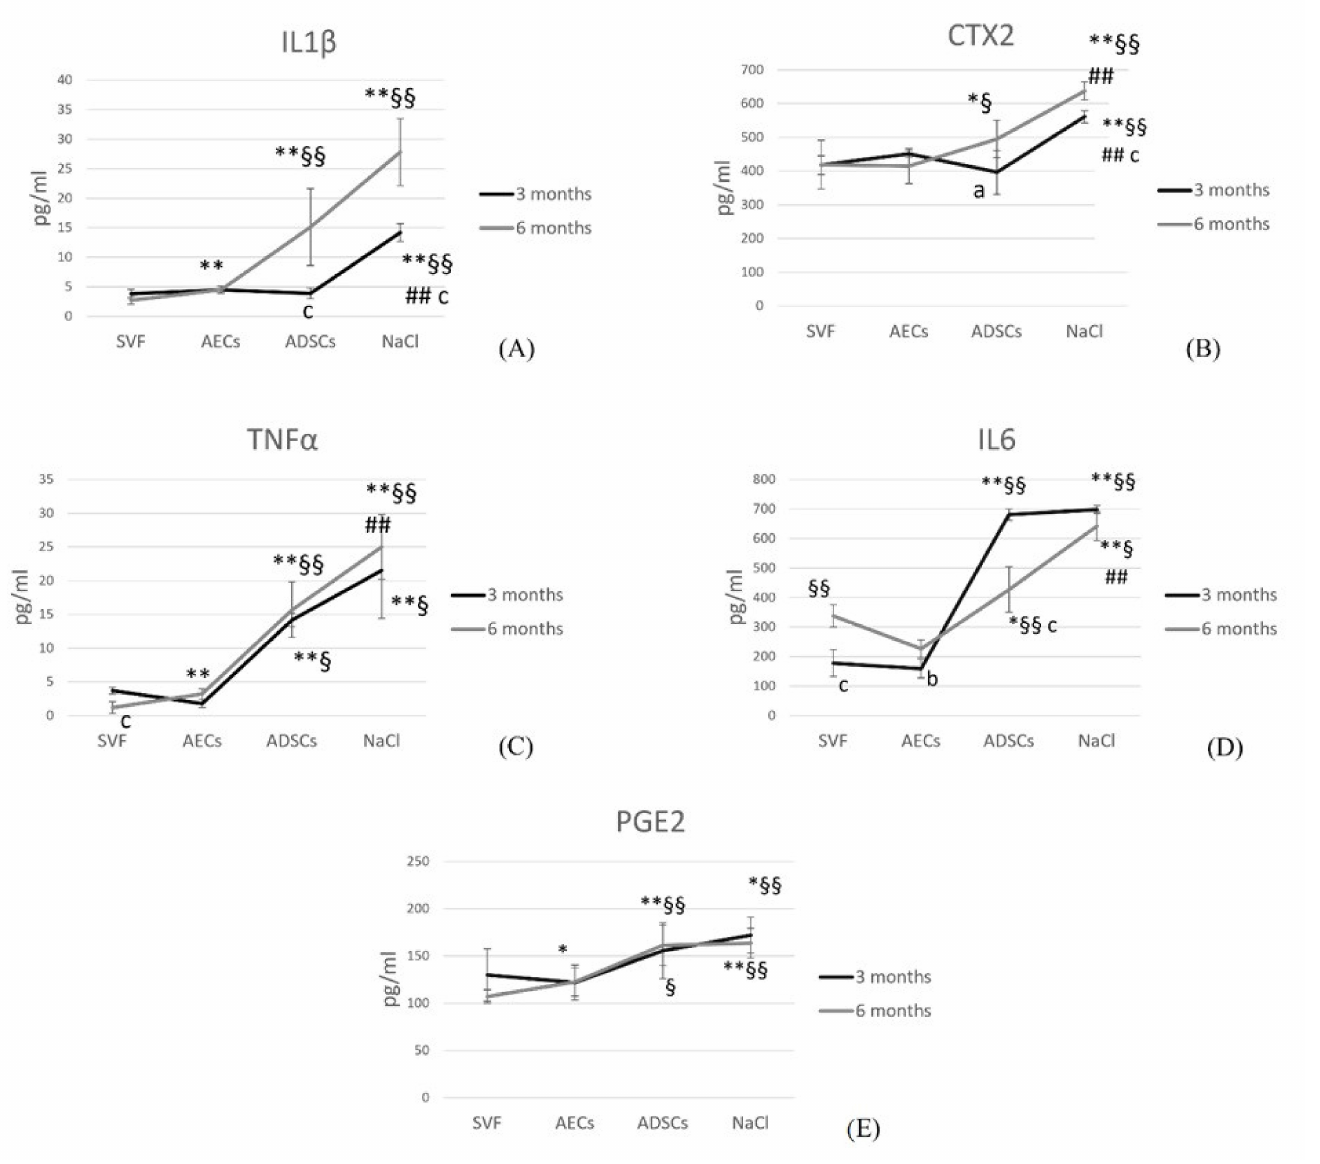
Figure 6. Line graphs of pro-inflammatory cytokine quantification (pg/mL) in the synovial fluid: IL1 β ( A ), CTX2 ( B ), TNF α ( C ), IL6 ( D ), PGE2 ( E ), in all treatment groups: SVF, AECs, ADSCs and NaCl at 3 (black line) and 6 (grey line) months. N = 6. *, p < 0.05; **, p < 0.005: SVF vs. AECs, ADSCs and NaCl; §, p < 0.05; §§, p < 0.005: AECs vs. ADSCs and NaCl; ##, p < 0.005: ADSCs vs. NaCl. a, p < 0.05; b, p < 0.005; c, p < 0.0005: 6 mo vs. 3